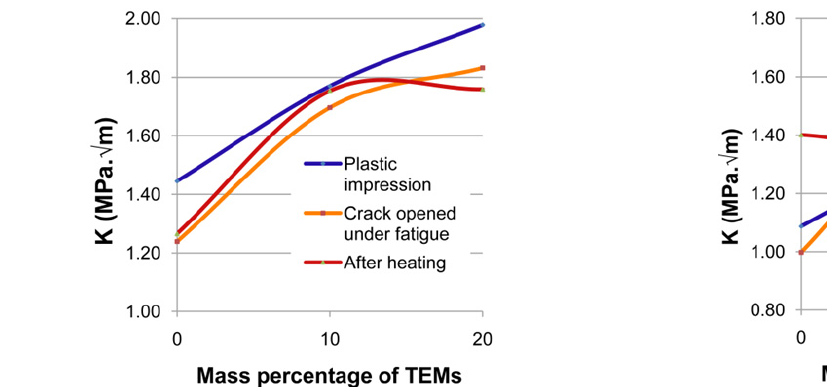
Figure 7: Fracture toughness as a function of TEMs mass fraction for adhesive 2015.